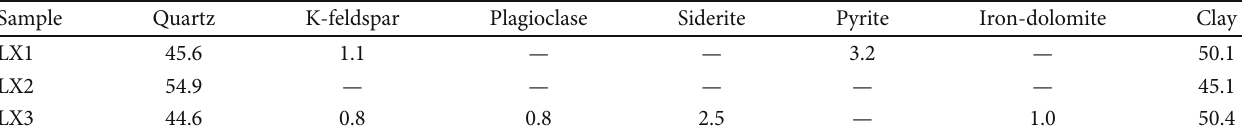
Table 2: Mineral contents of tight gas sandstones (wt.%).